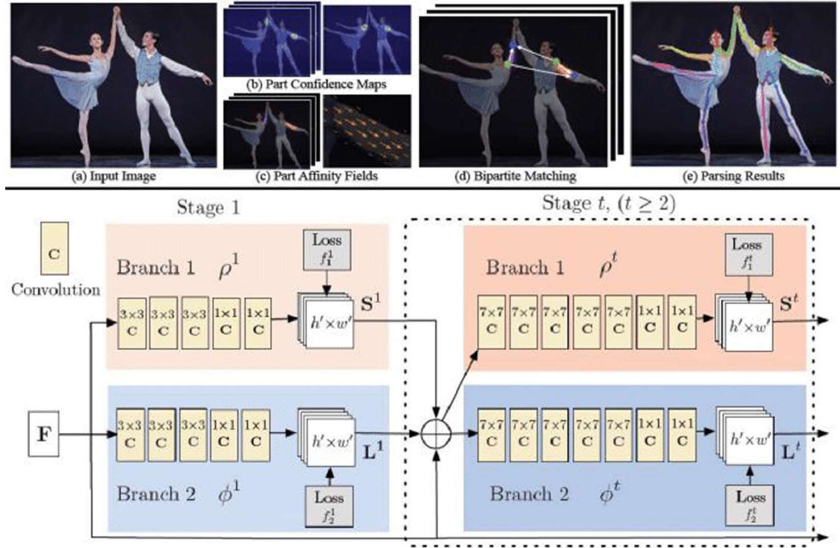
Figure 3. OpenPose Architecture. When the image of ( a ) is input, it detects the joint using the VGG-19 model, one of the CNN models, and creates the heatmap of ( b ). Based on the heatmap, the PAF of ( c ) is constructed for the correlation analysis of joints, and the joints are properly divided and connected as shown in ( d ) to obtain the result of ( e